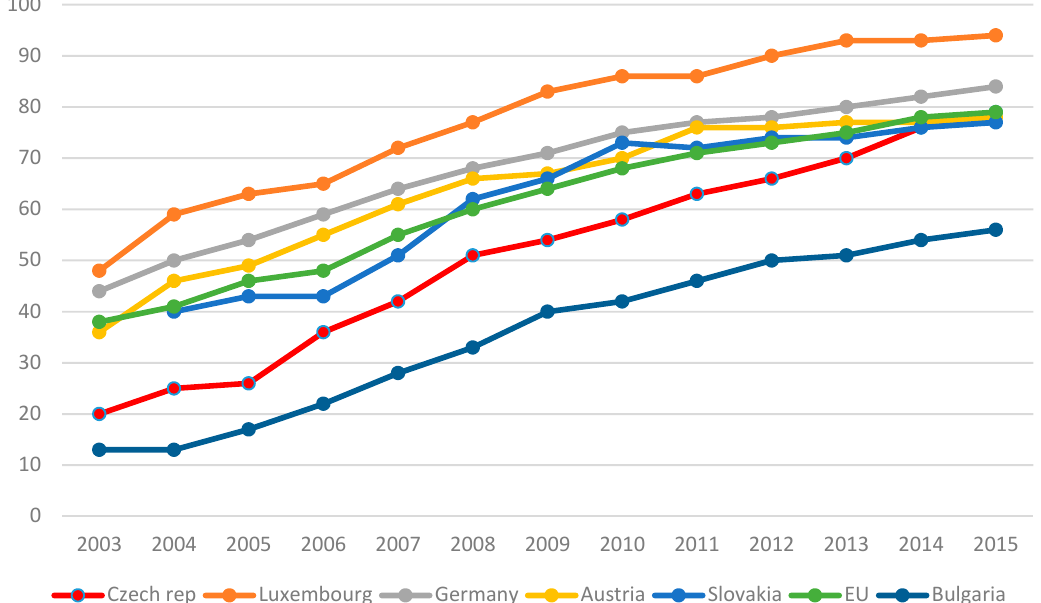
Figure 2. Internet availability in selected countries in 2003–2015 in relative terms per capita.